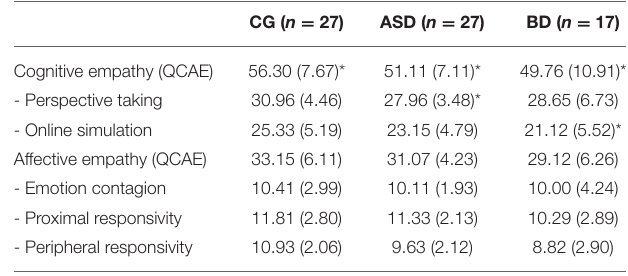
TABLE 4 | Means (standard deviations) for cognitive and affective empathy, and their subscales.